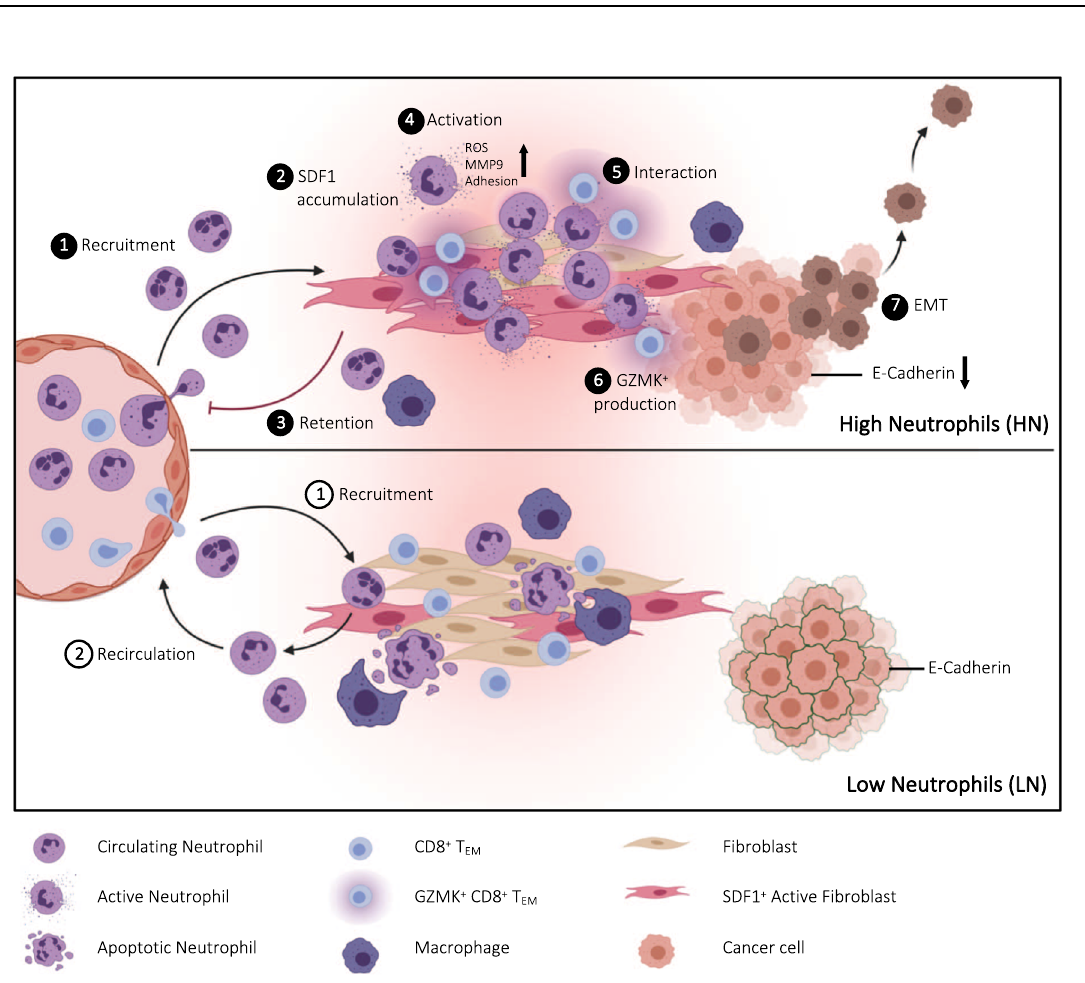
blue, E-Cadherin green. Scale bar 100 μ m. Bars represent mean±SEM or box and whiskerplotsindicateMintoMaxvalue,two-tailedunpairedttest( A , B , E , F , I ),two- tailedtwo-wayAnova( C ),two-tailedone-wayAnova( G ,correctedwithFisher ’ sLSD test, H ). Source data are provided as a Source Data fi le.